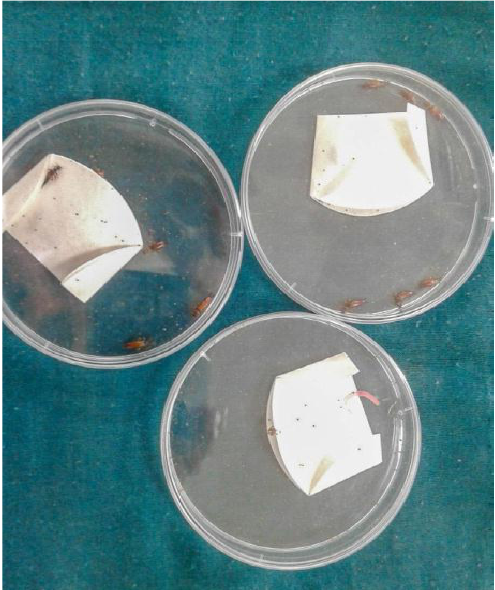
Figure 1. Petri dishes containing packet filter paper as the setup for eggs and larvae